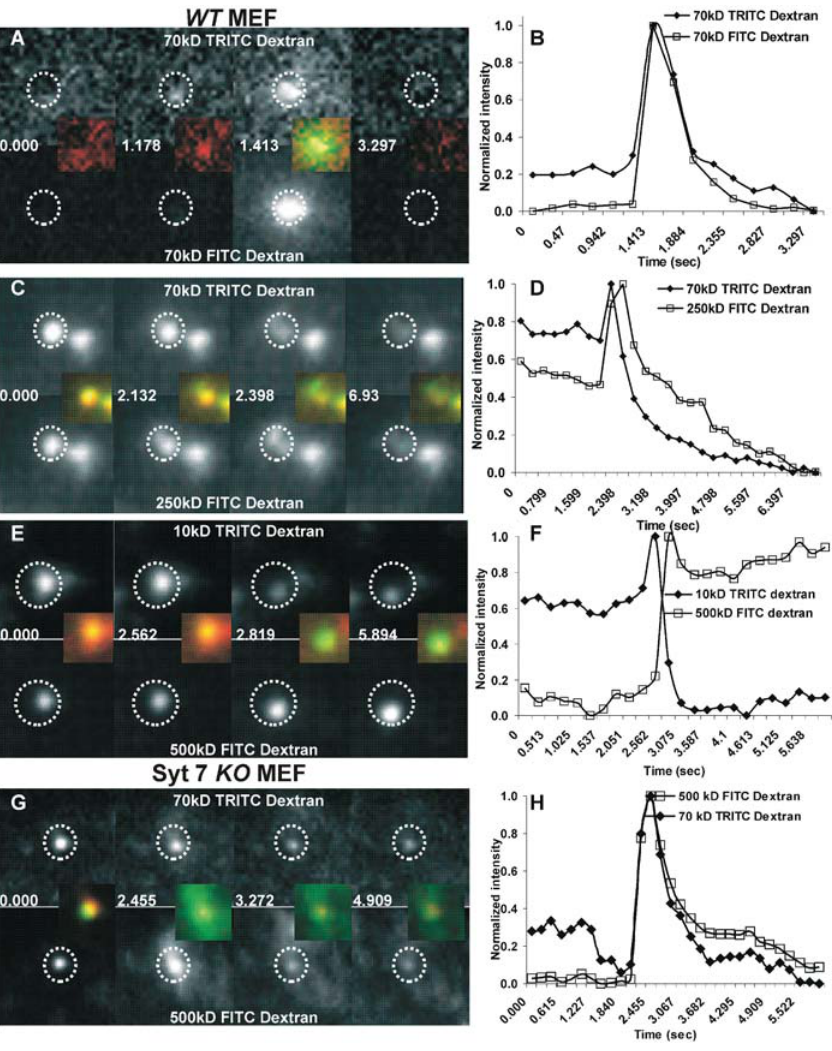
Figure 3. Presence of Syt VII Restricts the Size of the Fusion Pore The lumen of lysosomes was loaded simultaneously using different-sized FITC- and TRITC-labeled dextran, using the approach described in Figures 1 and 2. Representative plots shown here dem- onstrate the fate of both dextran pop- ulations in individual lysosomes following the increase in intracellular calcium by addition of calcium iono- phore. In WT MEFs, exocytosing lyso- somes that released 70 kDa TRITC– dextran also simultaneously released 70 kDa FITC–dextran (A and B), 250 kDa FITC–dextran (C and D), but not 500 kDa FITC–dextran (E and F). In Syt VII KO MEFs, lysosomes that released 70 kDa TRITC–dextran also released 500 kDa FITC–dextran (G and H). In all cases the plots represent the normalized fluores- cence intensity of the region marked in the images by dotted circles. DOI: